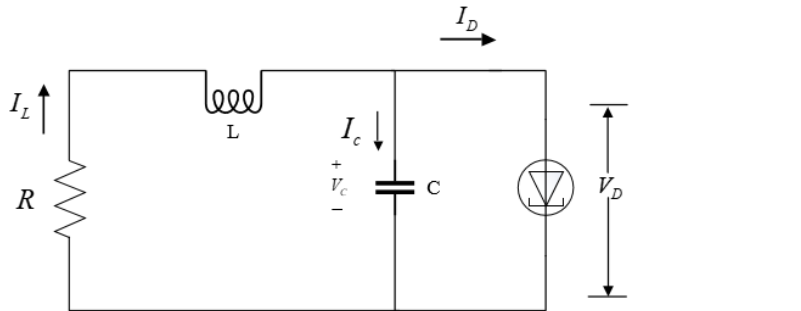
Figure 1. Tunnel diode